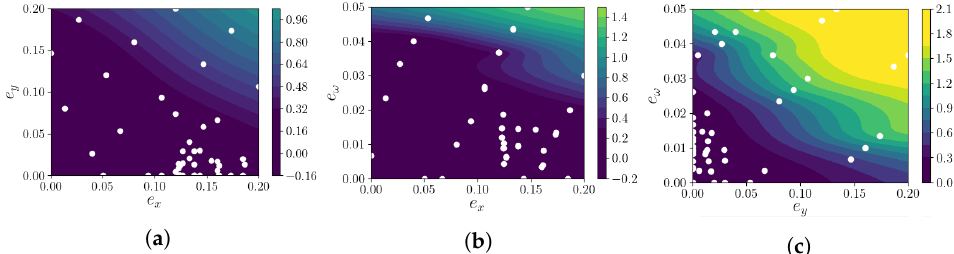
Figure 5. Verification measure with respect to parameters as approximated by gp ver . ( a ) e x vs. e y , e ω constant. ( b ) e x vs. e ω , e y constant. ( c ) e y vs. e ω , e x